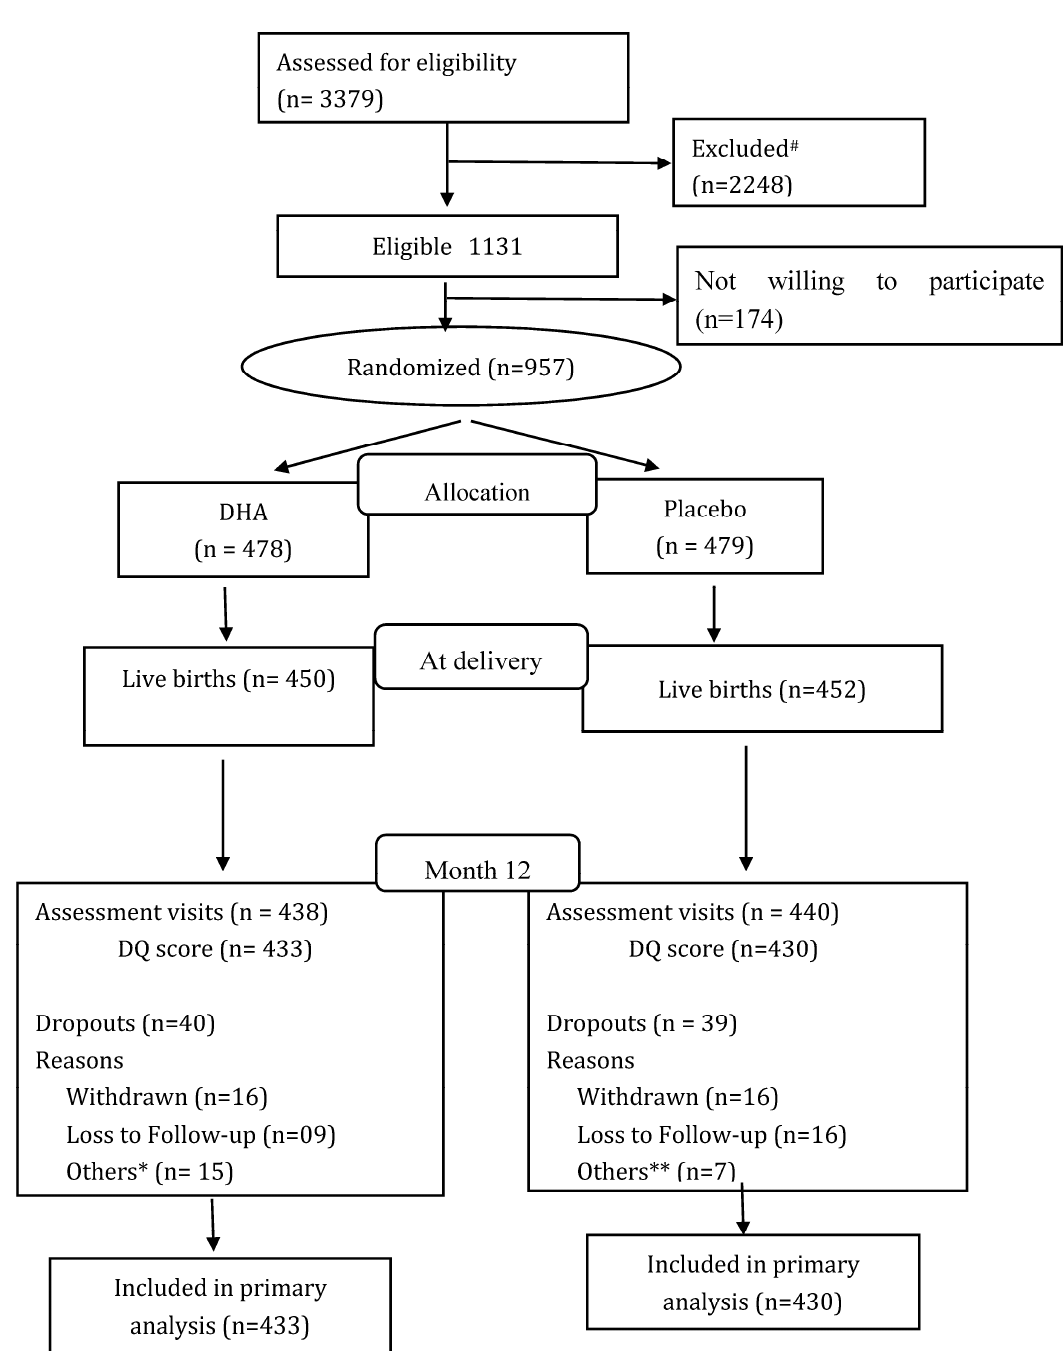
Figure 1. Consort. # Reasons for exclusion: gestational diabetes (n = 69); Hb < 7 gm% (n = 46); gestational age >20 weeks (n = 673); high-risk pregnancies (n = 118); chronic conditions (n = 246); under any other trial (n = 4); delivery plan other than PK (n = 835); missing / wrong contact information (n = 257). * Others included: abortion (n = 1); abruptio placenta (n = 1); fresh stillbirth (n = 4); macerated stillbirth (n = 3); neonatal death (n = 2); maternal death (n = 1); congenital anomalies (n = 1); infant death (n = 2) in DHA group. ** Others included: fresh stillbirth (n = 4); macerated stillbirth (n = 2); medical termination (n = 1) in Placebo